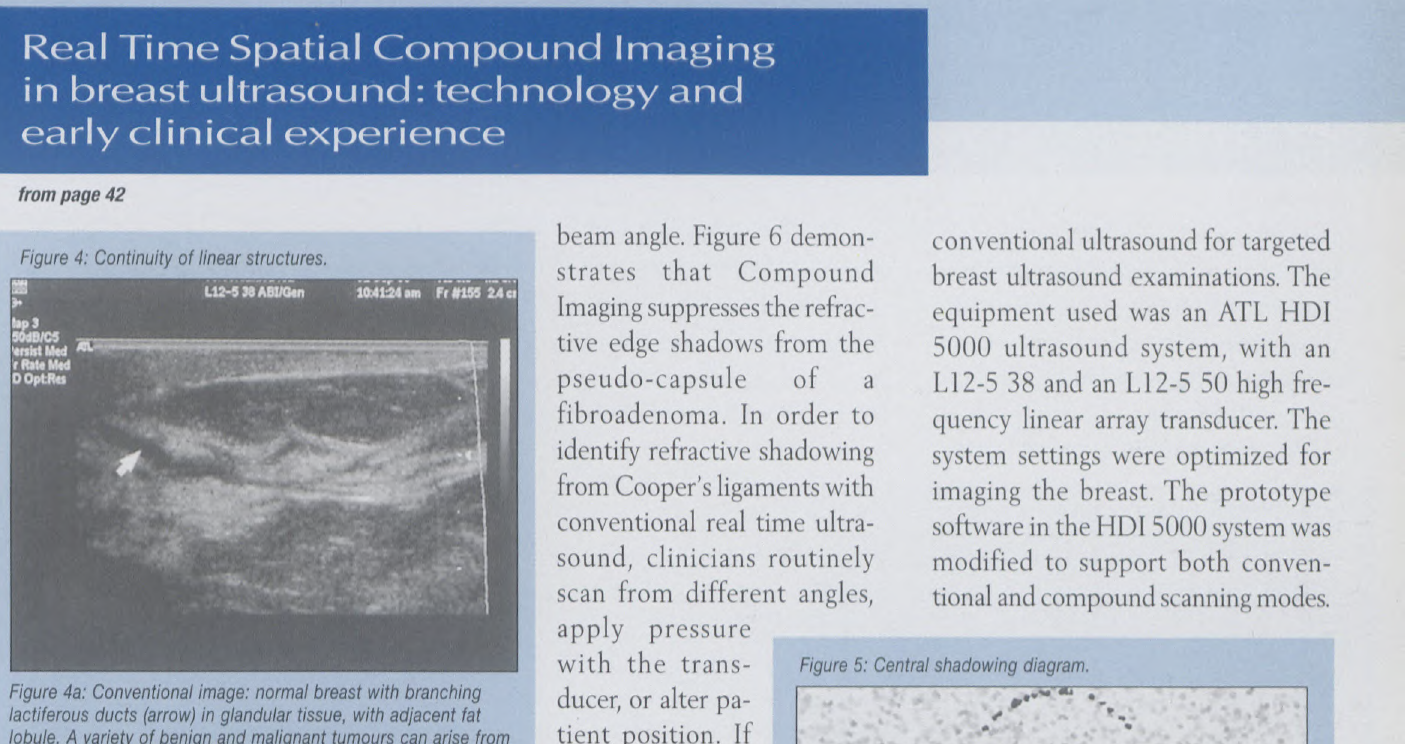
Figure 5: Central shadowing diagram.